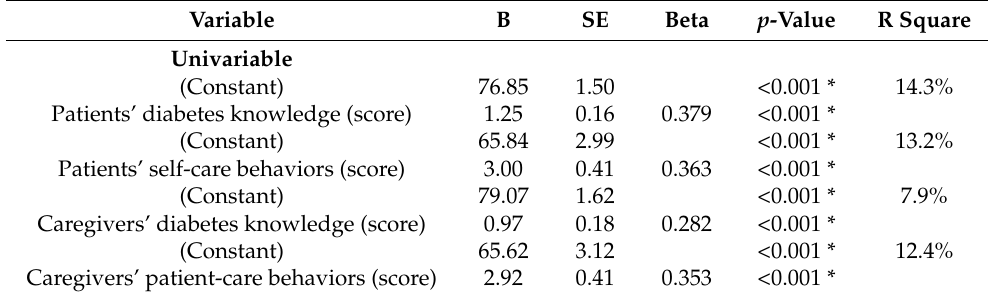
Table 5. Relationship between diabetes knowledge and behavior for both groups and patients’ QoL.